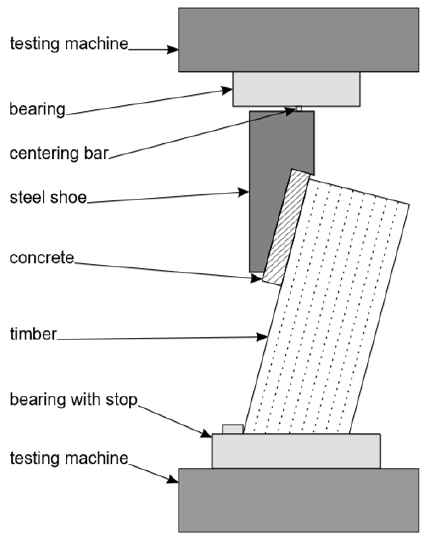
Figure 6. Technical drawing of experimental test setup of inclined bond tests